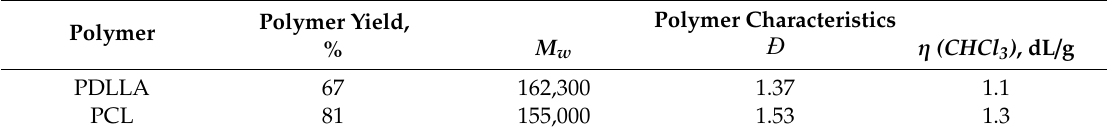
Table 1. Characteristics of the matrix polymers used for the preparation of composite materials. Polymer